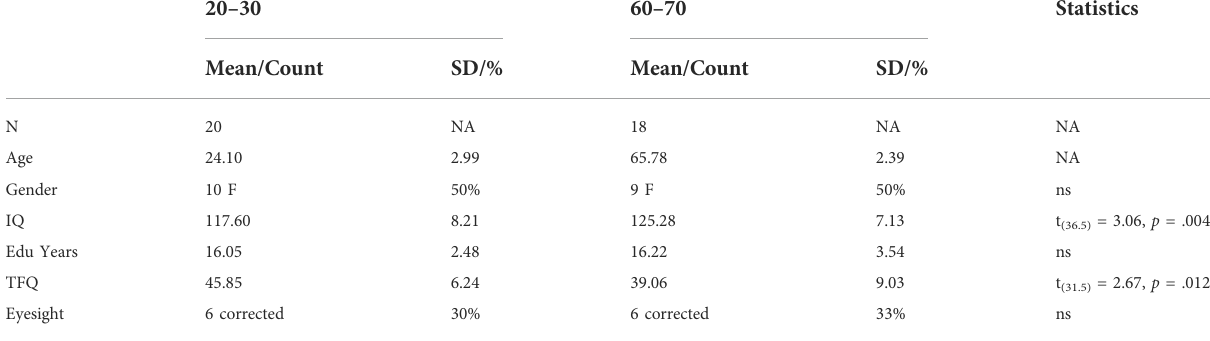
TABLE 3 Study 2 demographic